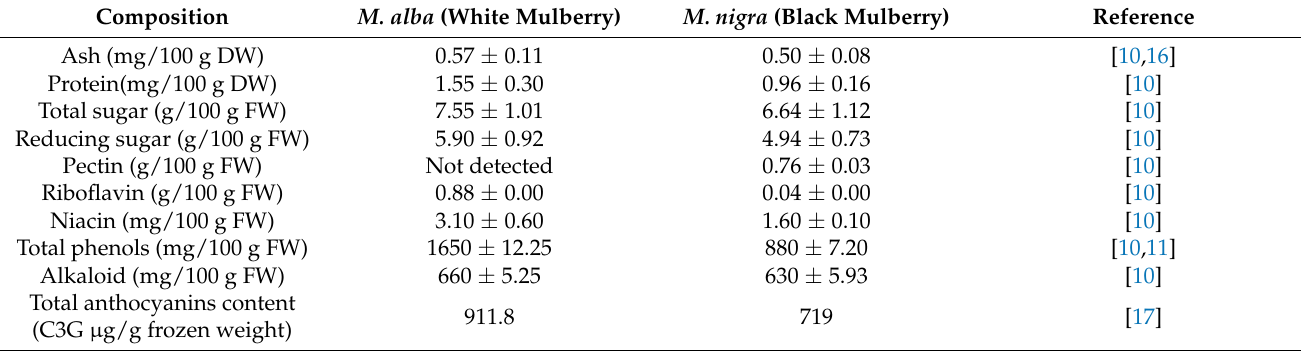
Table 1. Proximal composition, sugar, pectin, total phenol, and alkaloid of two species of mulberry. Composition M. alba (White